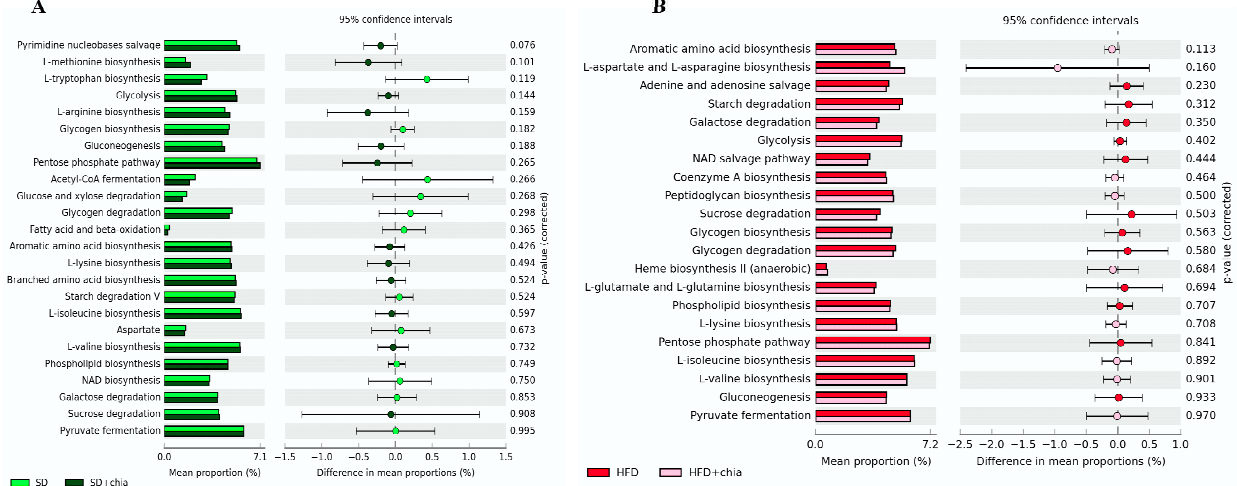
Figure 5. Difference in the relative abundance of the most abundant KEGG microbial metabolic pathways in the microbiota of young Wistar rats, after 35 days of treatment. ( A ) Enriched pathways between the SD and SD+chia treatment groups. ( B ) Enriched pathways between the HFD and HFD+chia treatment groups. Extended error bar plot was performed by bioinformatic software (STAMP). Welch’s two-sided test was used and Welch’s inverted was 0.95. n = 6/group. SD: standard diet; SD+chia: standard diet + chia; HFD: high-fat diet; HFD+chia: high-fat diet + chia.